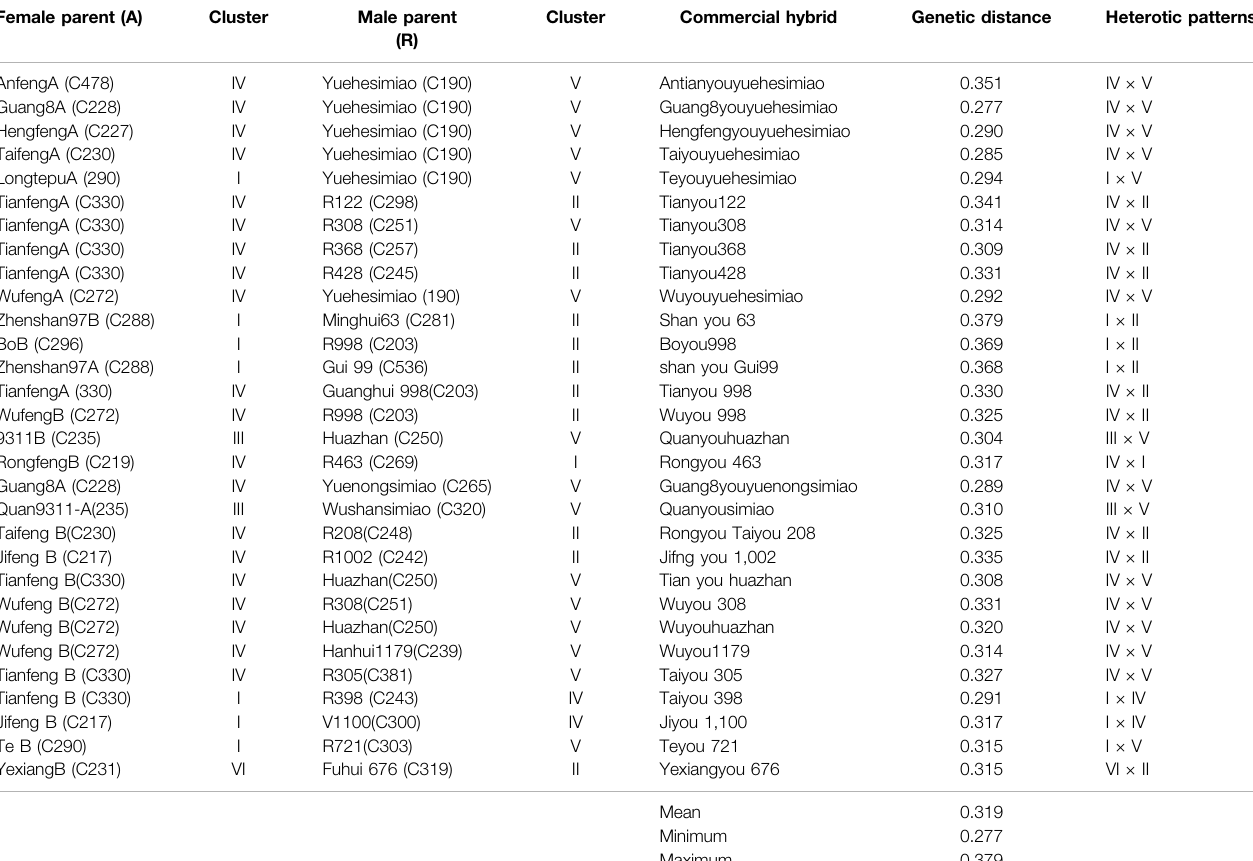
TABLE 2 | Heterotic groups used for commercial hybrid production, genetic distance, and their deduced heterotic patterns. Female parent